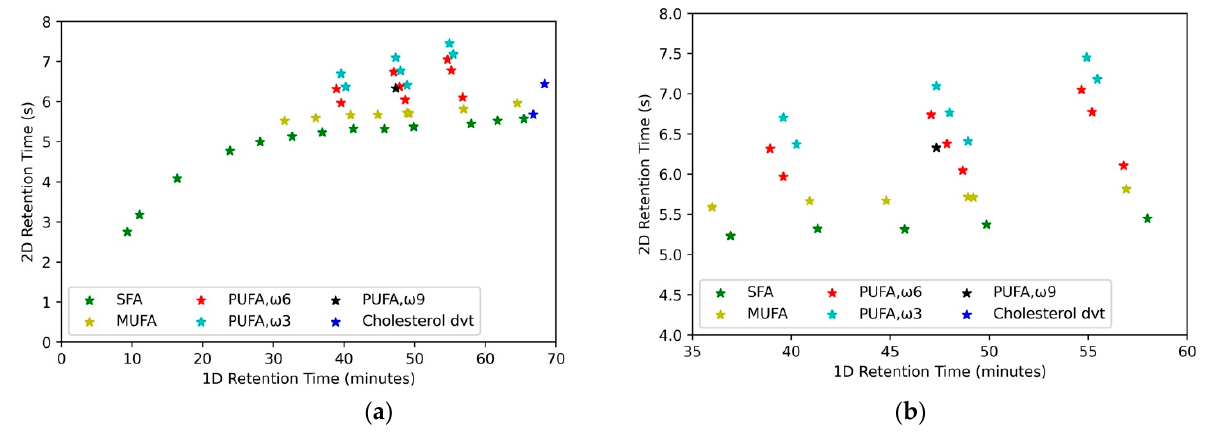
Figure 4. ( a ) Reconstructed contour plot of pig serum. ( b ) Zoomed-in reconstructed contour plot for C 18 to C 22 region for pig serum.